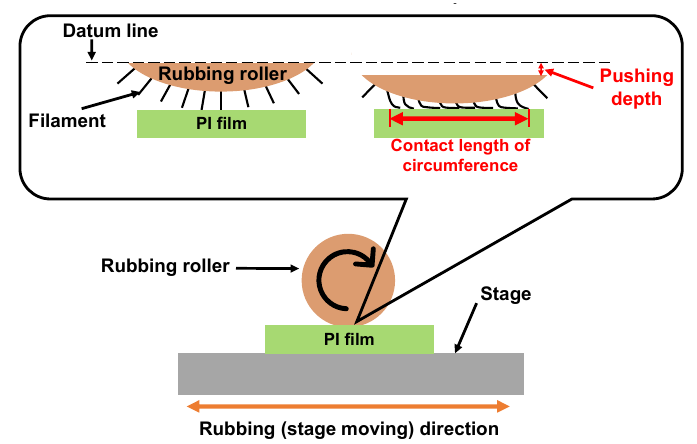
Figure 13. Illustration of the rubbing treatment process for PI film.